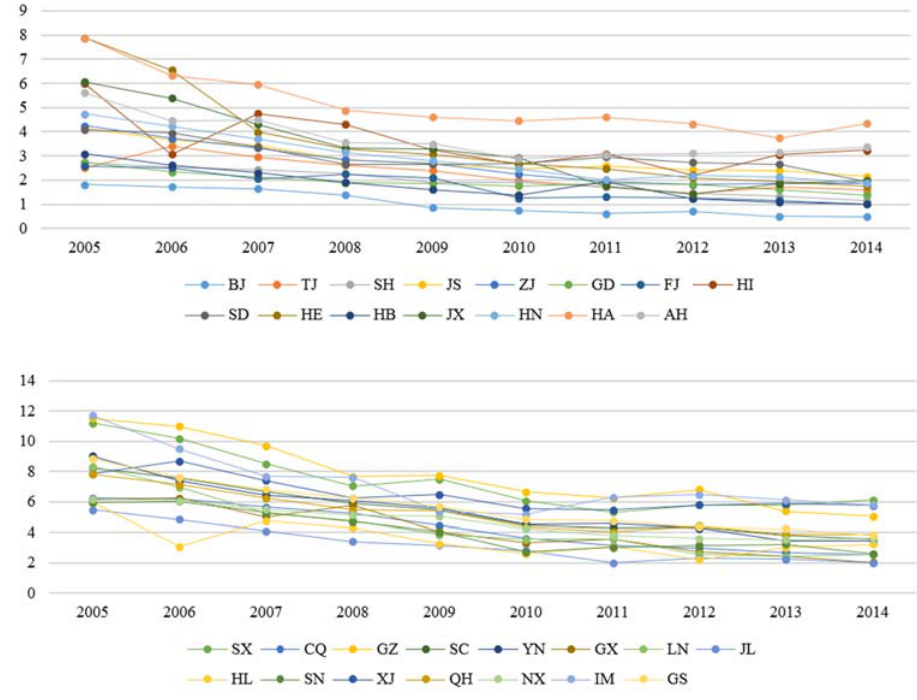
Figure 2. China’s provincial construction industry carbon intensity in 2005–2014.